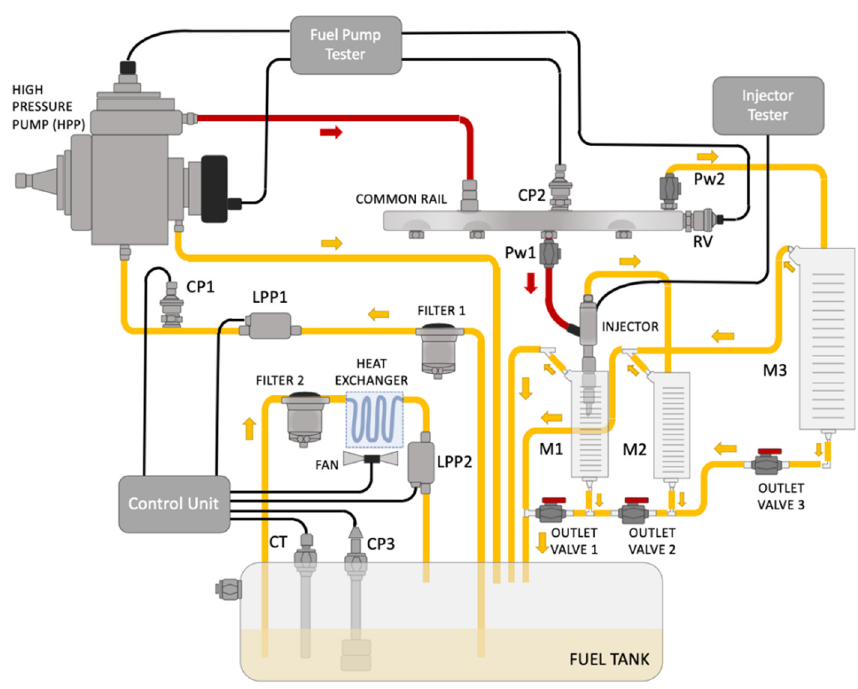
Figure 1. A schematic of the flow test bench.